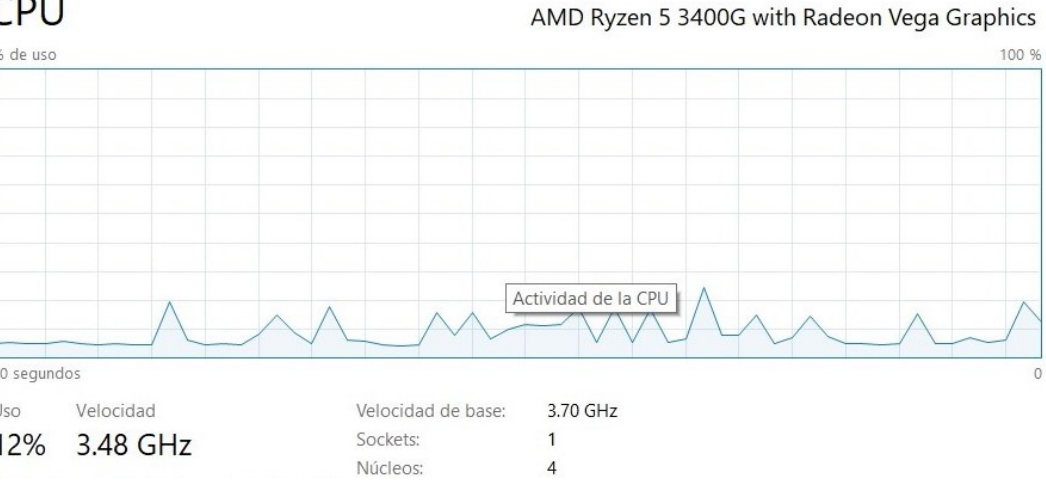
Figure 9. The CPU performance